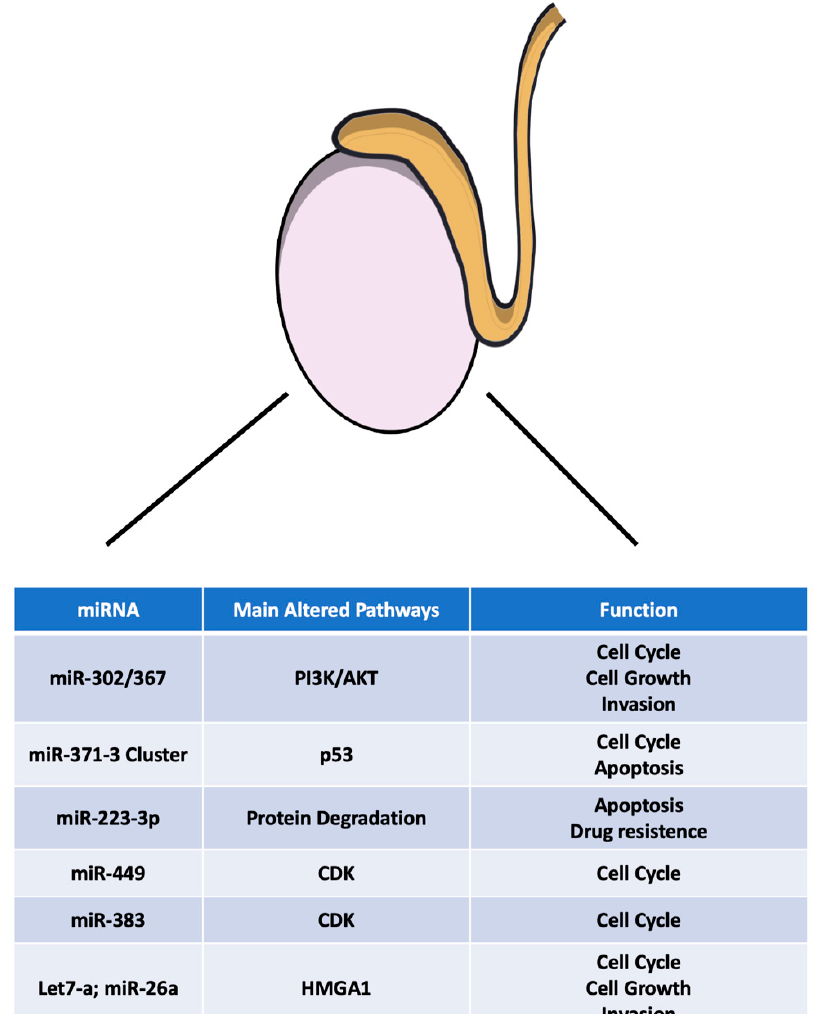
Figure 1. Main microRNAs deregulated in TGCTs. PI3K: Phosphoinositide 3-kinase; AKT: CDK: cyclin-dependent kinase